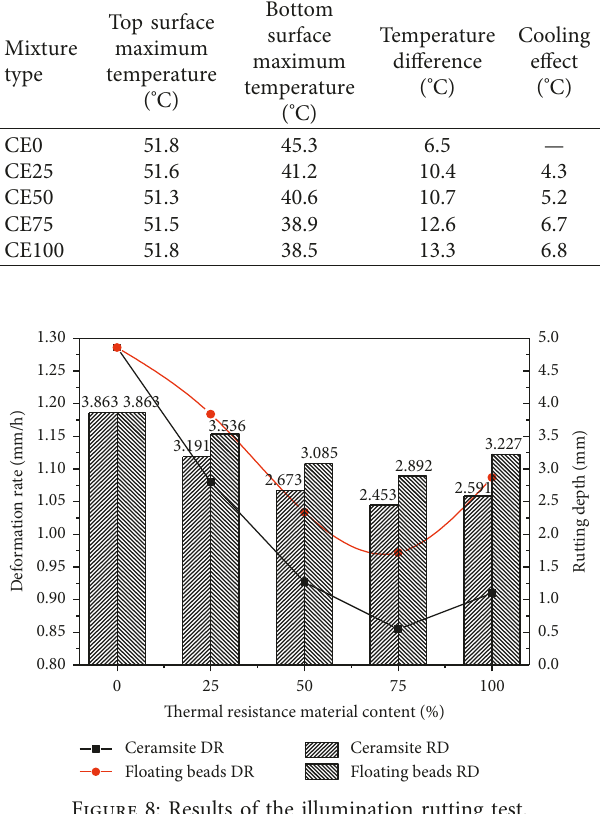
Figure 8: Results of the illumination rutting test.